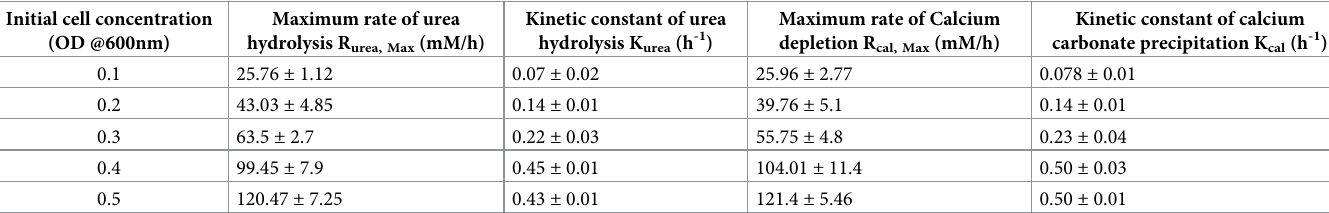
Table 3. Kinetic parameters associated with urea hydrolysis and CaCO 3 precipitation. Initial cell concentration (OD